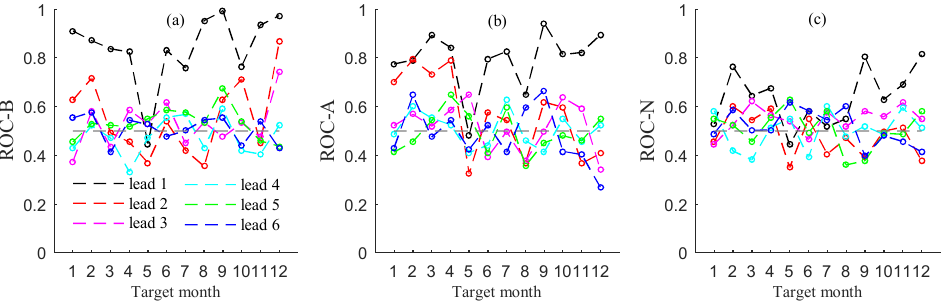
Figure 8. Variation of ROC areas for ( a ) below-normal, ( b ) above-normal, and ( c ) near-normal with the target month for six lead times for the Xijiang River.